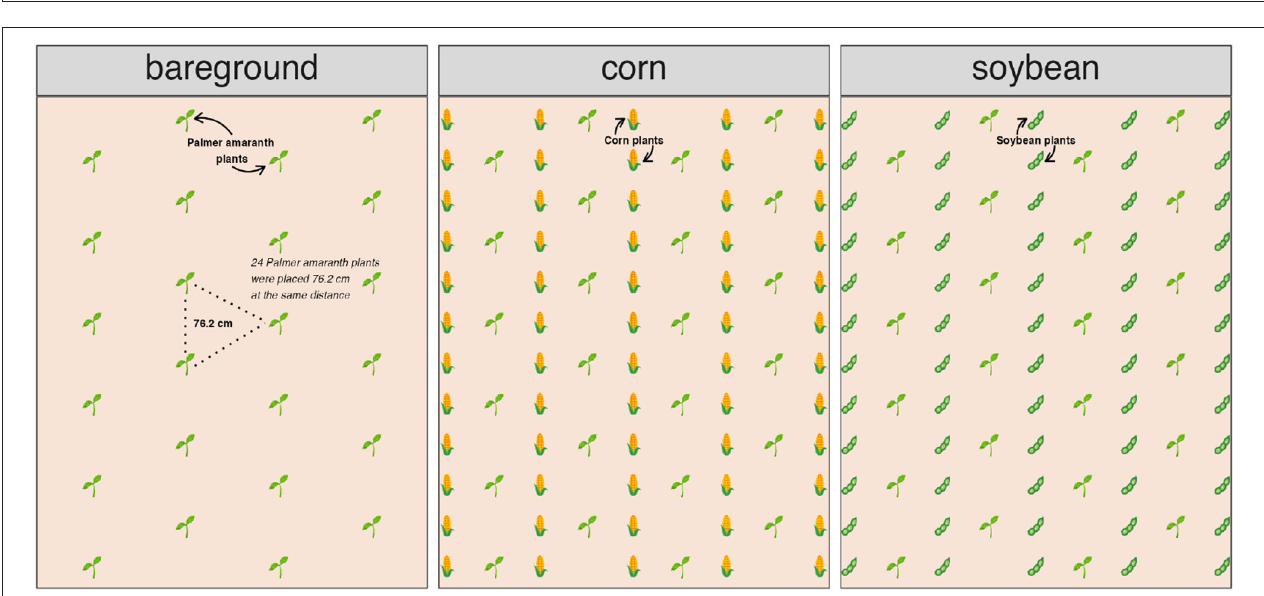
being female increased by 0.1 and 0.2% for each unit increase in weight and height, respectively ( Table 2 ).